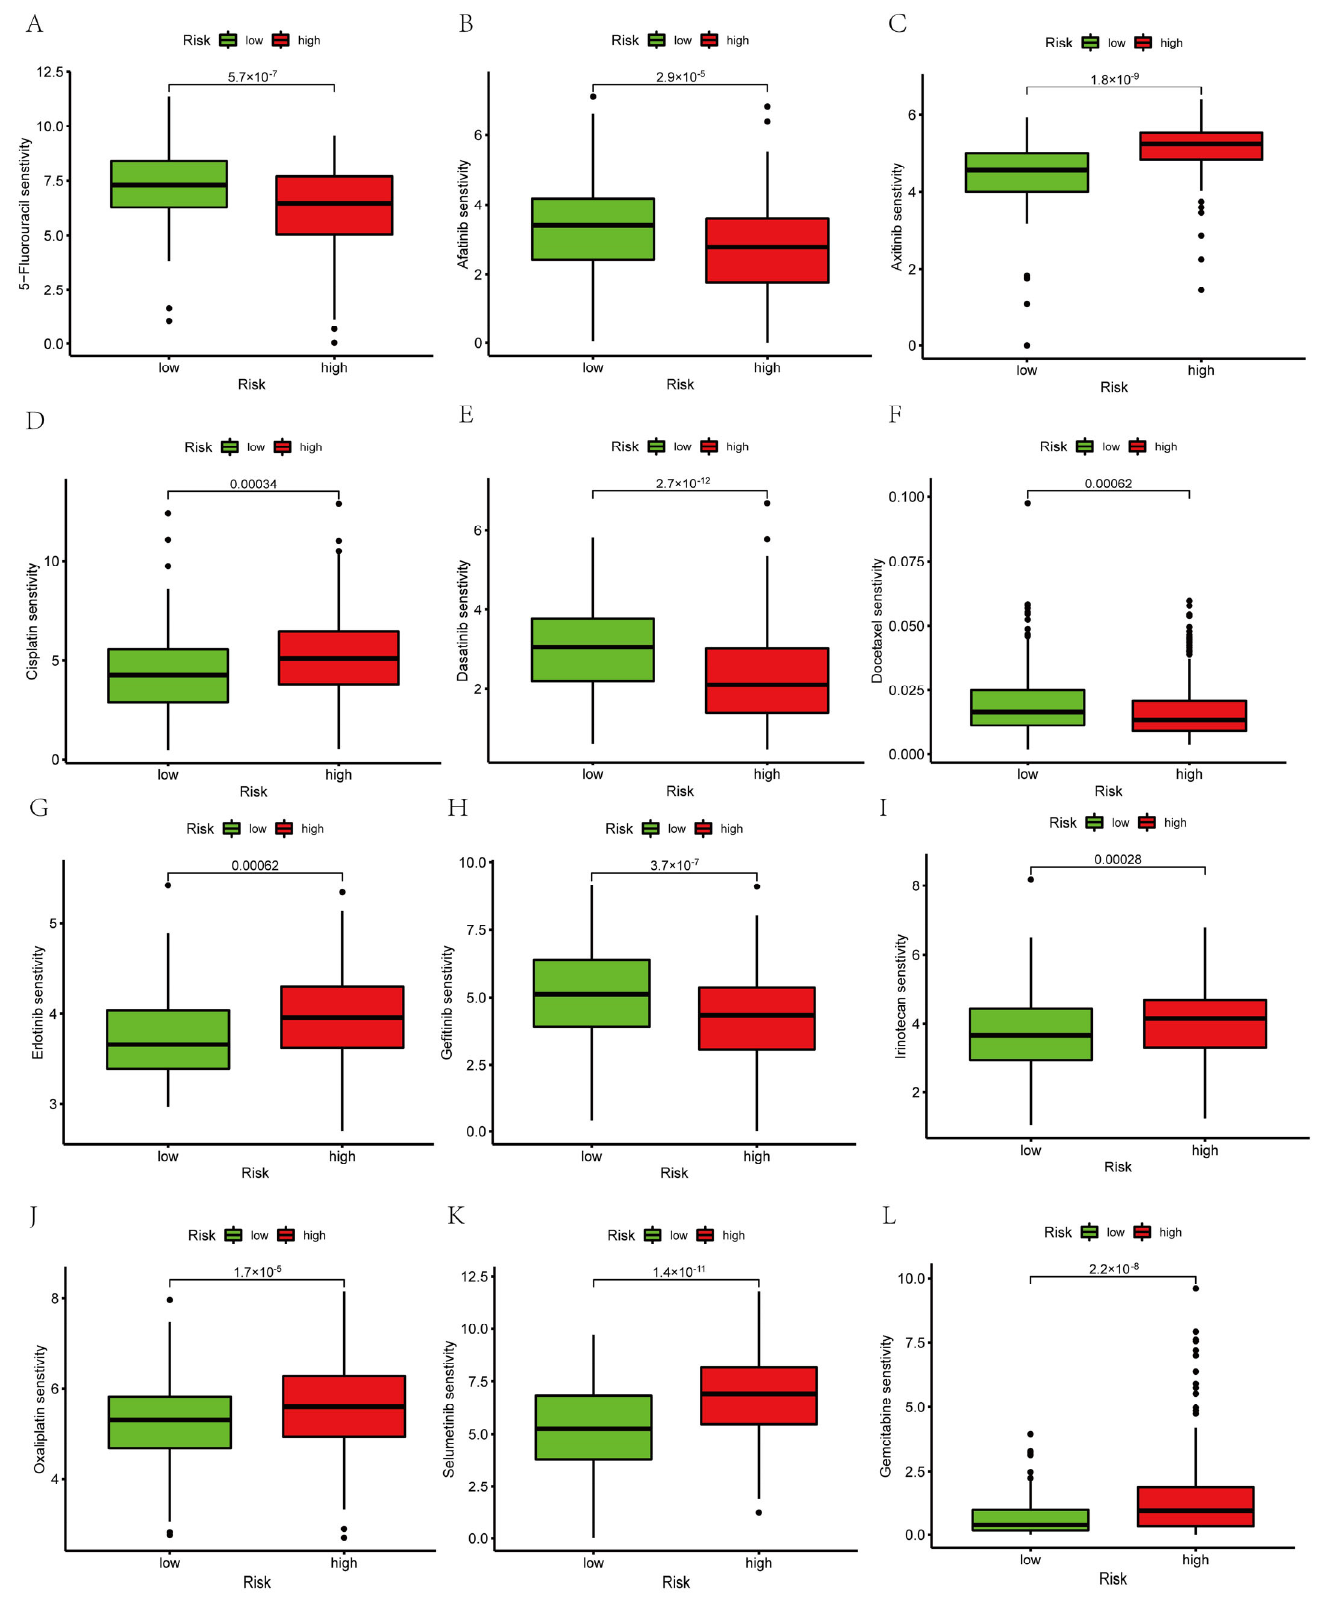
Figure 11. Aggrephagy-Related LncRNA signature predicts targeted drug sensitivity. ( A ) 5 − Fluorouracil. ( B ) Afatinib. ( C ) Axitinib. ( D ) Cisplatin. ( E ) Dasatinib. ( F ) Docetaxel. ( G ) Erlotinib. ( H ) Gefitinib. ( I ) Irinotecan. ( J ) Oxaliplatin. ( K ) Selumetinib. ( L ) Gemcitabine,